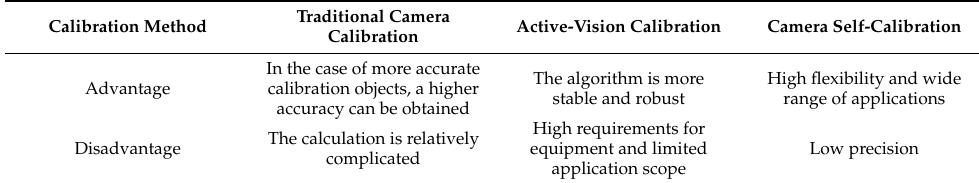
Table 1. Comparison of camera-calibration methods